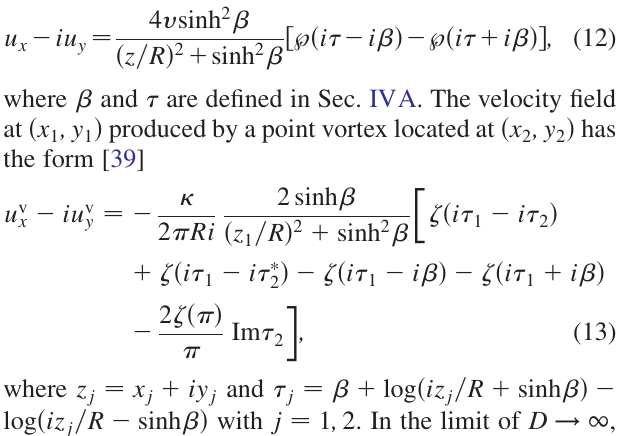
FIG. 6. (a)–(c) Dynamics ofthedensity profiles j c j 2 =n fortwo 0 Þ ¼ 5 , d=(cid:2) ¼ 4 : 5 , and D=(cid:2) ¼ = ð gn Gaussian potentials with V 0 0 22 in the rest frame. The potentials are moved as in Eq. (8) with ¼ 0 : 24 and T=t ¼ 150 . The arrows in (a) and (c) indicate =v v 0 s 0 the direction of the displacement of the potentials and that of the propagation of the vortex dipole, respectively. (d) Phase profile ¼ 140 . The topological defects in the dashed arg c at ~ t ¼ t=t 0 circle are the counterpart of the launched vortex dipole. The field of view of each panel is 90 (cid:2) (cid:5) 65 (cid:2) . (See also Supplemental Material [31].) (e) Velocity of the launched vortex dipole versus distance D between the two Gaussian potentials. The parameters except D are the same as those in